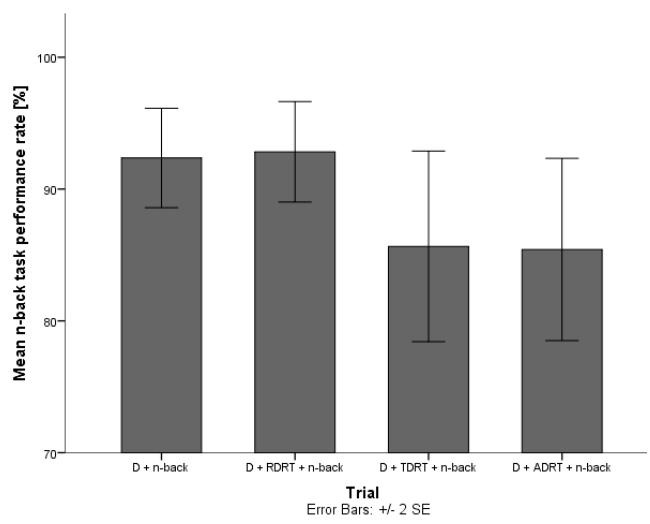
Figure 10. Mean task performance rate for trials without and with DRT stimuli [38].